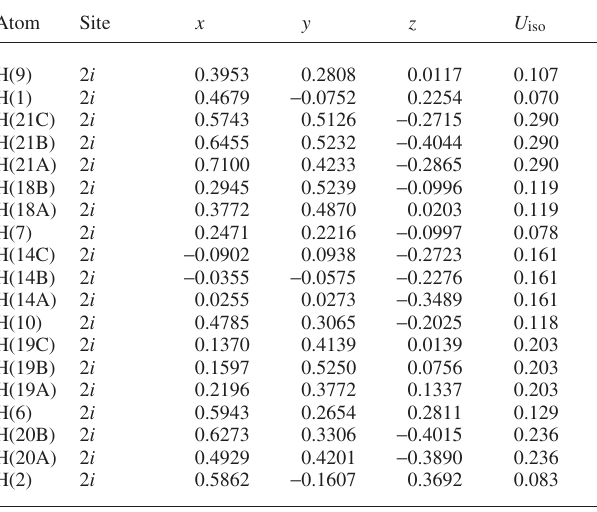
Table 2. Atomic coordinates and displacement parameters (in Å 2 )